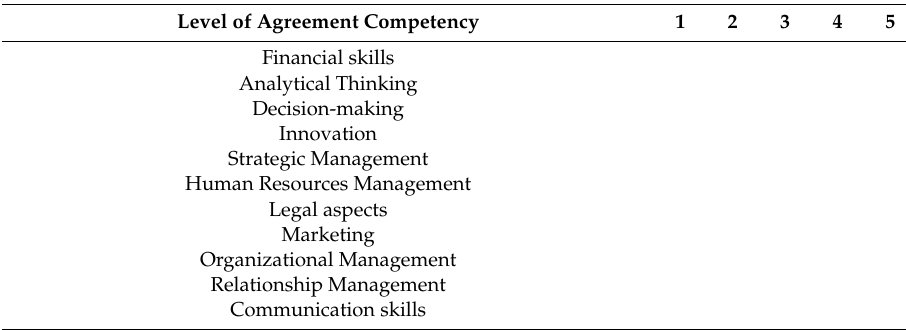
Table A1. List of